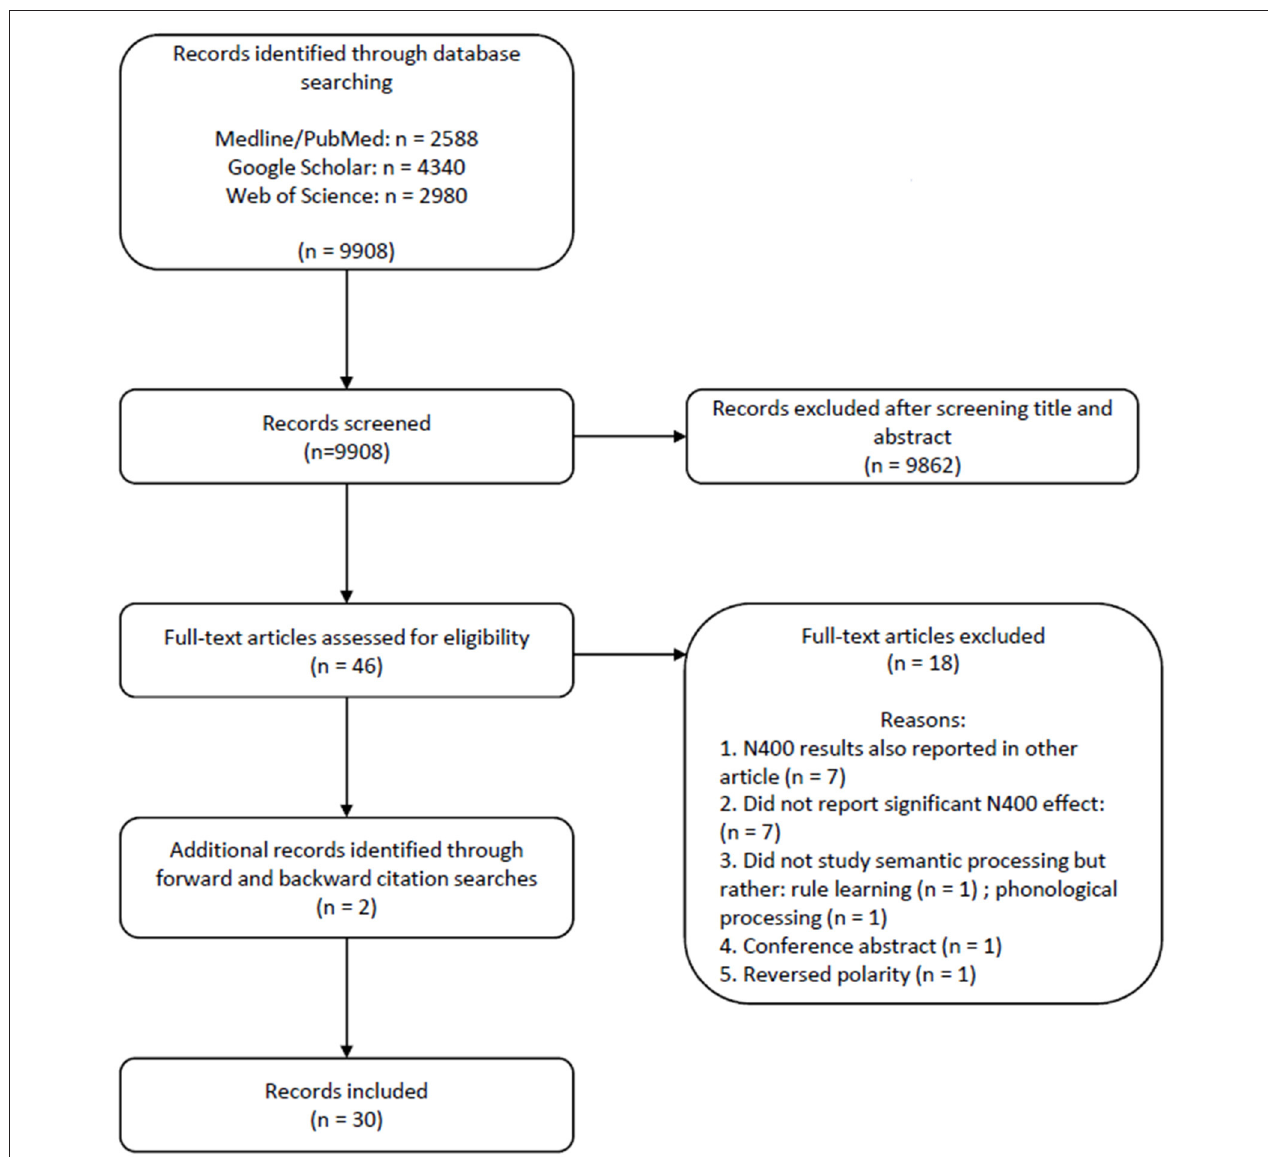
FIGURE 1 | PRISMA flow diagram of the systematic literature search process (Moher et al.,